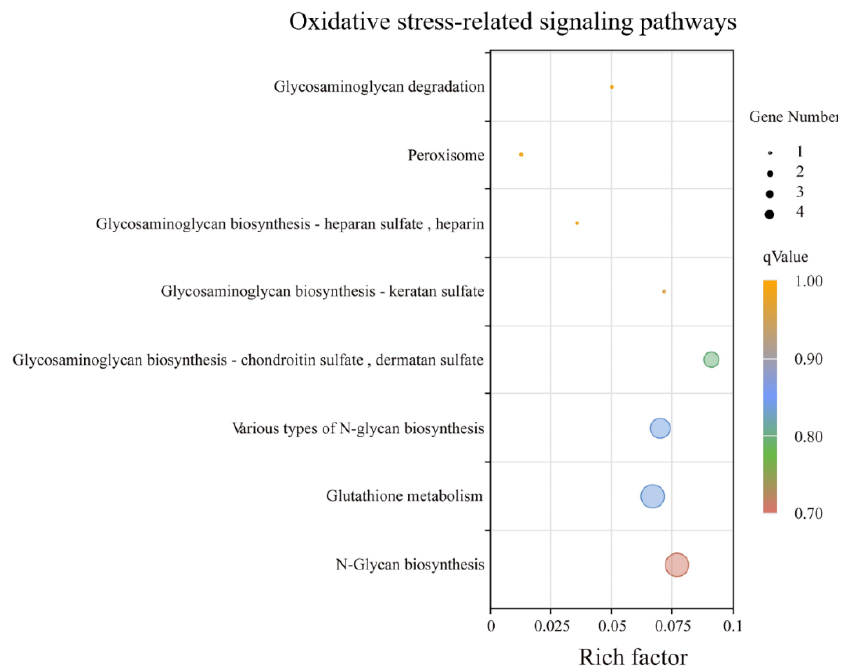
Figure 5. The results of KEGG enrichment analyses based on the upregulated genes in the treatment group compared to the control group.